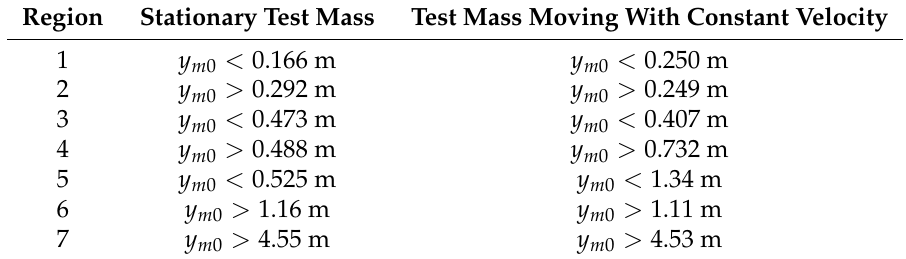
Table 2. Locations of regions of validity of the exact and approximate expressions for the stationary and moving test mass. The regions refer to Regions 1–7 given in the